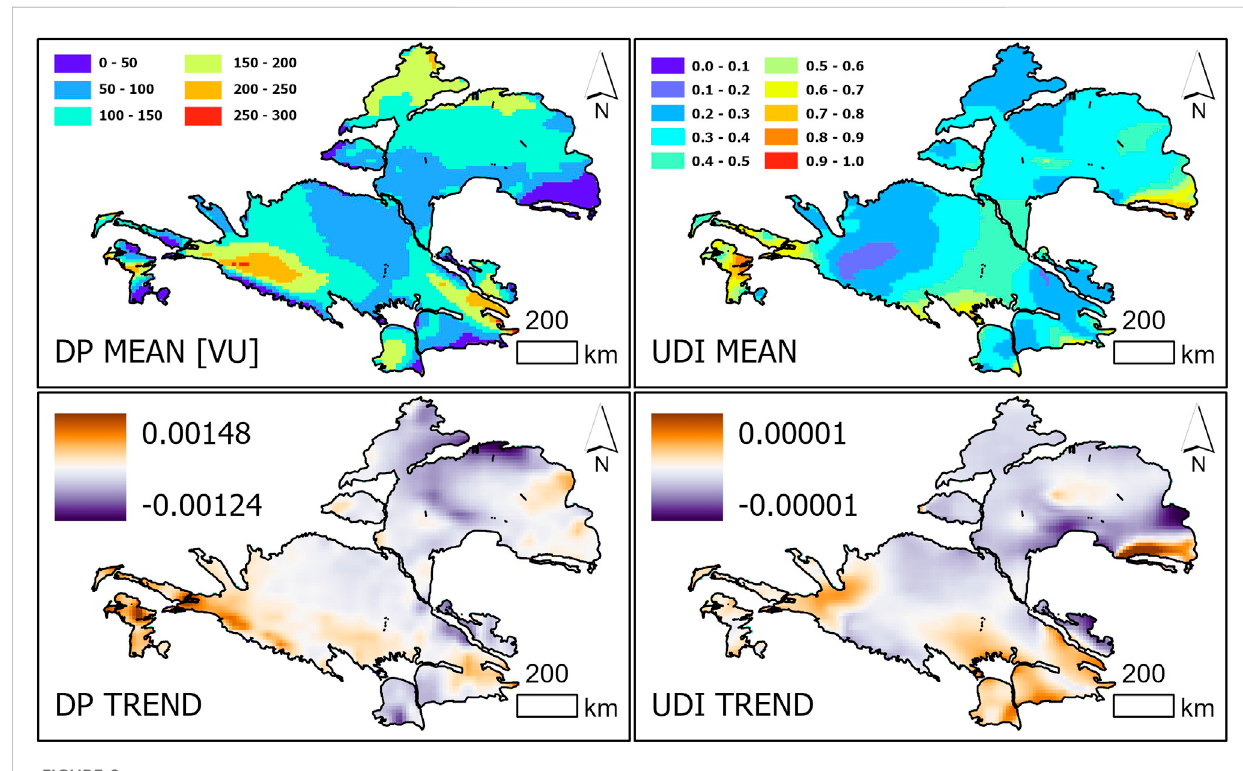
FIGURE 8 Space-time cubestatistical assessment.Averagedriftpotential (DP)and winddirectionalityindex(UDI)values,and theirlinear trendsofchangeover 70 years.